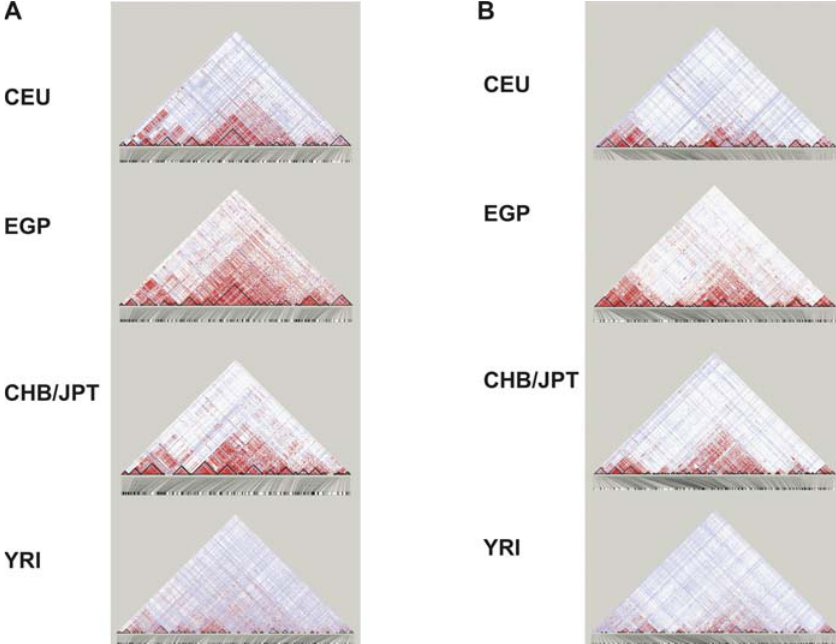
Figure 3. LD/Block Structure of the HapMap and Estonia Samples (A) ENCODE 1 region. (B) ENCODE 2 region. DOI: 10.1371/journal.pgen.0020027.g003